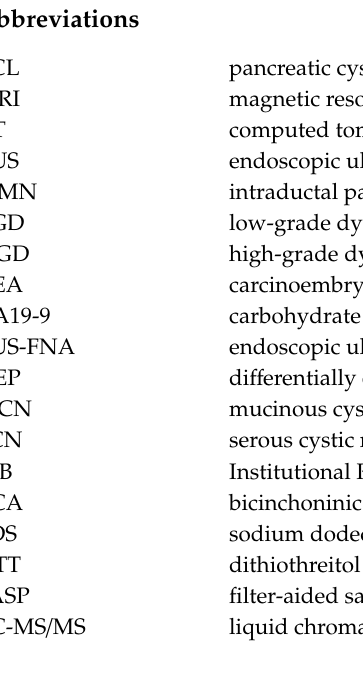
Figure S1: The number of identified and quantified proteins in individual samples and the peptide library, Figure S2: Dynamic range of quantified proteins, Figure S3: Coe ffi cient of variation (CV%) values of technical triplicates in each individual sample, Figure S4: Pearson correlation coe ffi cients between technical replicates in each sample group, Figure S5: Comparative analysis with various proteome databases and other proteomic studies, Figure S6: Comparison of the expression patterns of the final marker candidates between our previous and present studies, Figure S7: Flowchart of the discovery of potential markers of IPMN dysplasia, Figure S8: Venn diagram of di ff erentially expressed proteins in 3 comparative groups, Figure S9: Results of Gene Ontology (GO) and KEGG pathway analyses, Figure S10: Ingenuity Pathway Analysis, Figure S11: Thirteen potential biomarkers with expression patterns that were consistent with the degree of IPMN malignancy, Figure S12: Intraplate and interplate repeatability of CD55 by ELISA, Figure S13: Validation of CD55 as a potential marker by Western blot, Figure S14: Immunohistochemical staining of CD55 and MPO, Table S1: List of total identified protein groups, Table S2: Summary of MaxQuant searches in terms of identified and quantified proteins and peptides with and without the peptide library, Table S3: CV values of log2-transformed LFQ intensity sums of each technical replicate in individual samples, Table S4: Pearson correlation coe ffi cients of technical triplicates, Table S5: Expression patterns of final marker candidates in the previous study compared with the present study, Table S6: Statistical analysis results, Table S7: List of exclusively upregulated, exclusively downregulated, and up- or downregulated proteins in comparisons 1 to 3, Table S8: Results of GO and KEGG pathway analyses conducted with the DAVID bioinformatics tool, Table S9: Results of upstream regulator analysis in IPA, Table S10: Demographic and clinical information of the validation cohort used for the ELISA, Table S11: Intraplate and interplate repeatability of CD55 by ELISA, Table S12: Ponceau S staining as an alternative loading control to